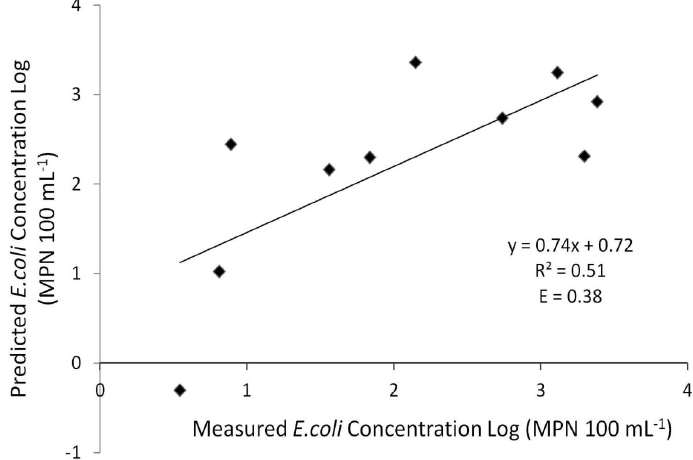
Figure 6. XY scatter of simulated versus observed E. coli concentrations (log transformed). Concentrations reflect bacteria concentrations at the study area gauging station.